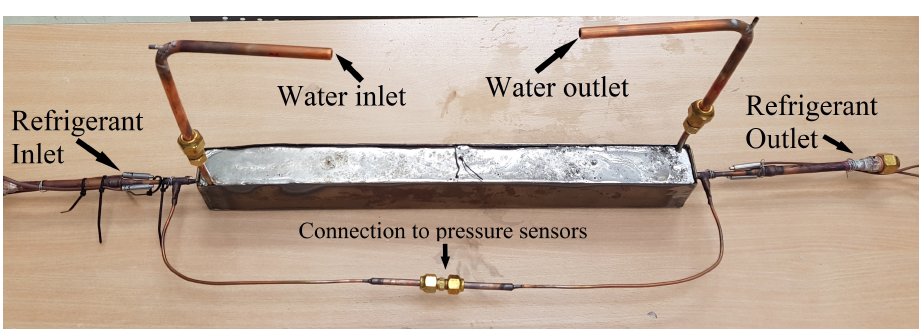
Figure 1. Test rig schematic.